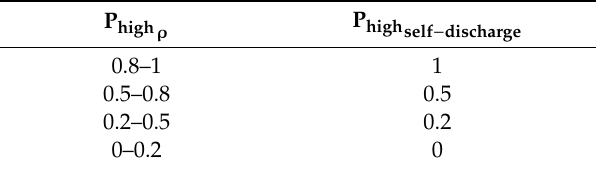
Table 7. Probabilities over a high self-discharge rate.